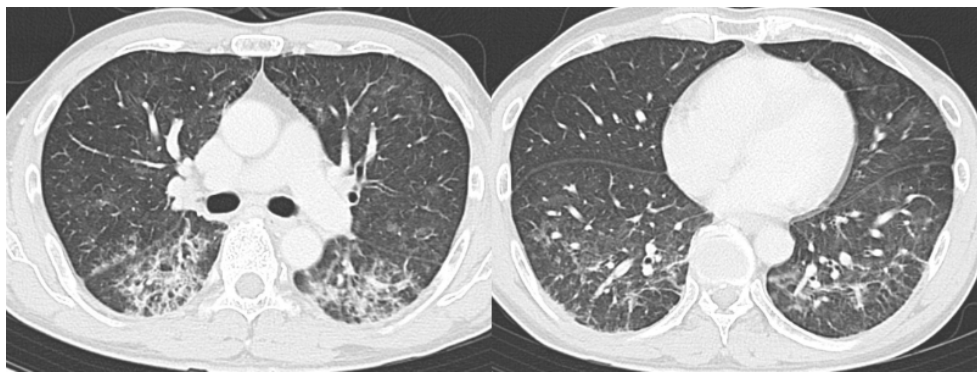
Figure 7. Example of a false-positive case (Case 2 ). Fifty-four-year-old female. The CT images show bilateral, peripheral posterior ground-glass opacities with consolidation with a lower lobe predominance. RT-PCR was negative for SARS-CoV-2. She had a history of medication use and was diagnosed with drug-induced pneumonia. Readers 1, 2, 3, and 4 diagnosed it as Categories 5, 4, 4, and 3, respectively. CT, computed tomography; RT-PCR, reverse transcription-polymerase chain reaction; SARS-CoV-2, severe acute respiratory syndrome coronavirus 2.